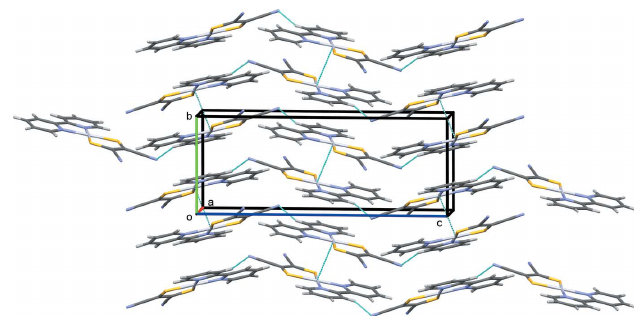
Figure 2 Aview of the inversion dimer of the title compound with select Pt1 (cid:2)(cid:2)(cid:2) Pt1 i and C2 (cid:2)(cid:2)(cid:2) C12 i /C12 (cid:2)(cid:2)(cid:2) C2 i distances in A˚ [symmetry code: (i) = (cid:6) x + 1, (cid:6) y + 1, (cid:6) z + 1].